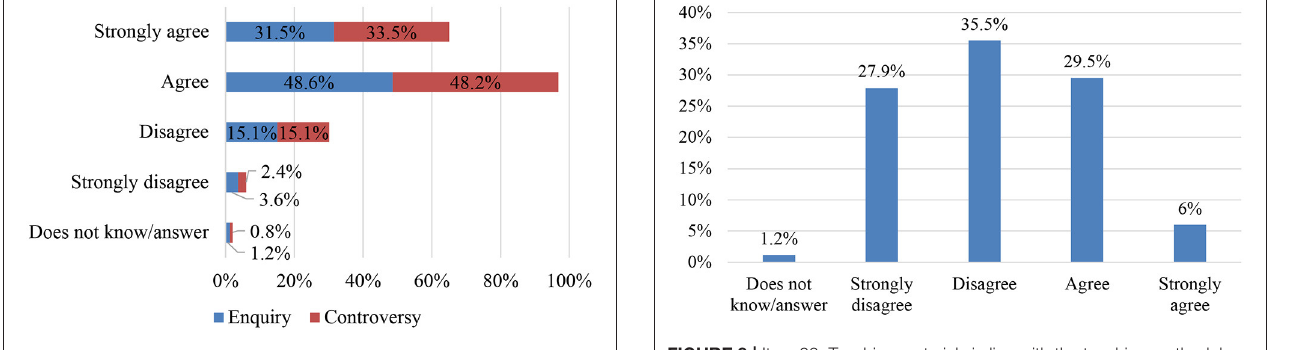
FIGURE 7 | Enquiry—controversy.